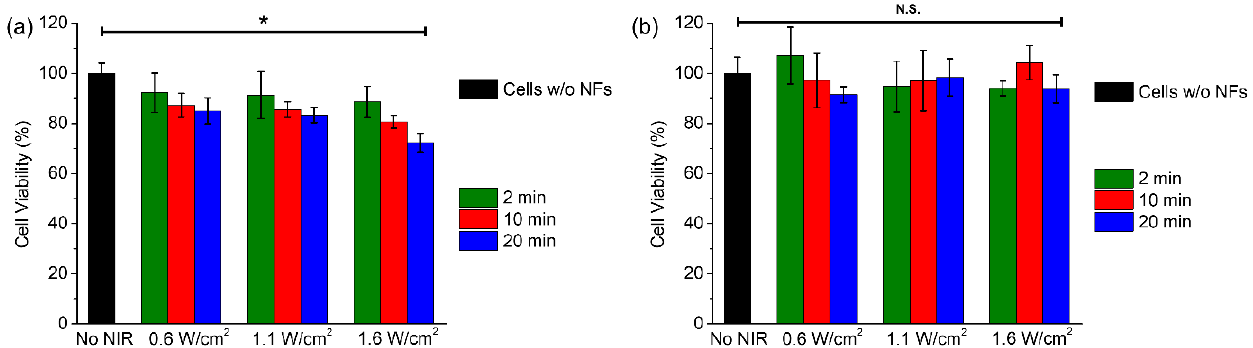
Figure 9. ( a ) Hyperthermia evaluation using the nanofibers containing GNRs with U87 cells. ( b ) NIR light toxicity for the U87 cells in the absence of the nanofibers. * p ≤ 0.05. N.S. indicates that the difference was not significant.